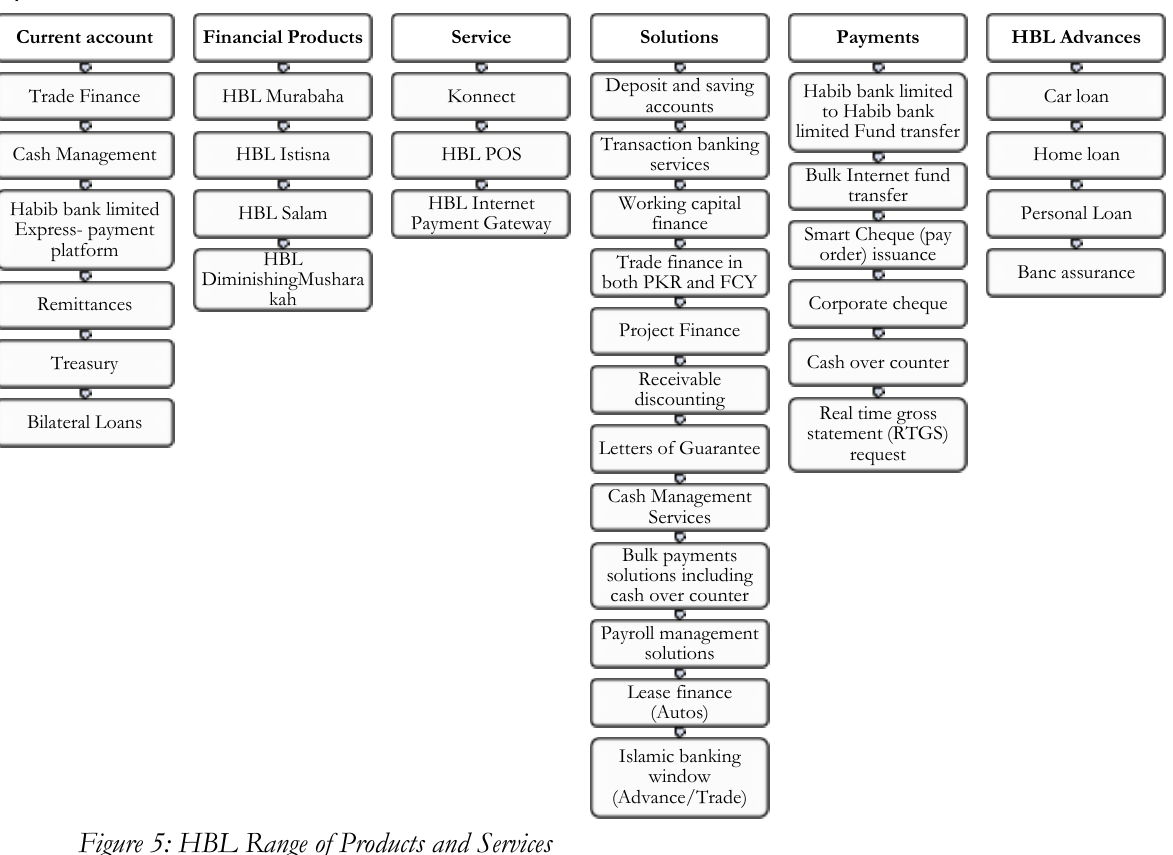
Figure 5: HBL Range of Products and